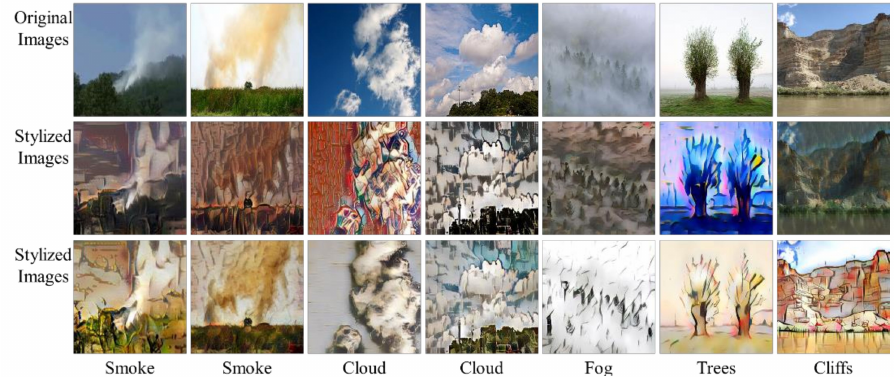
Figure 2. Sample images from the base domain and the stylized